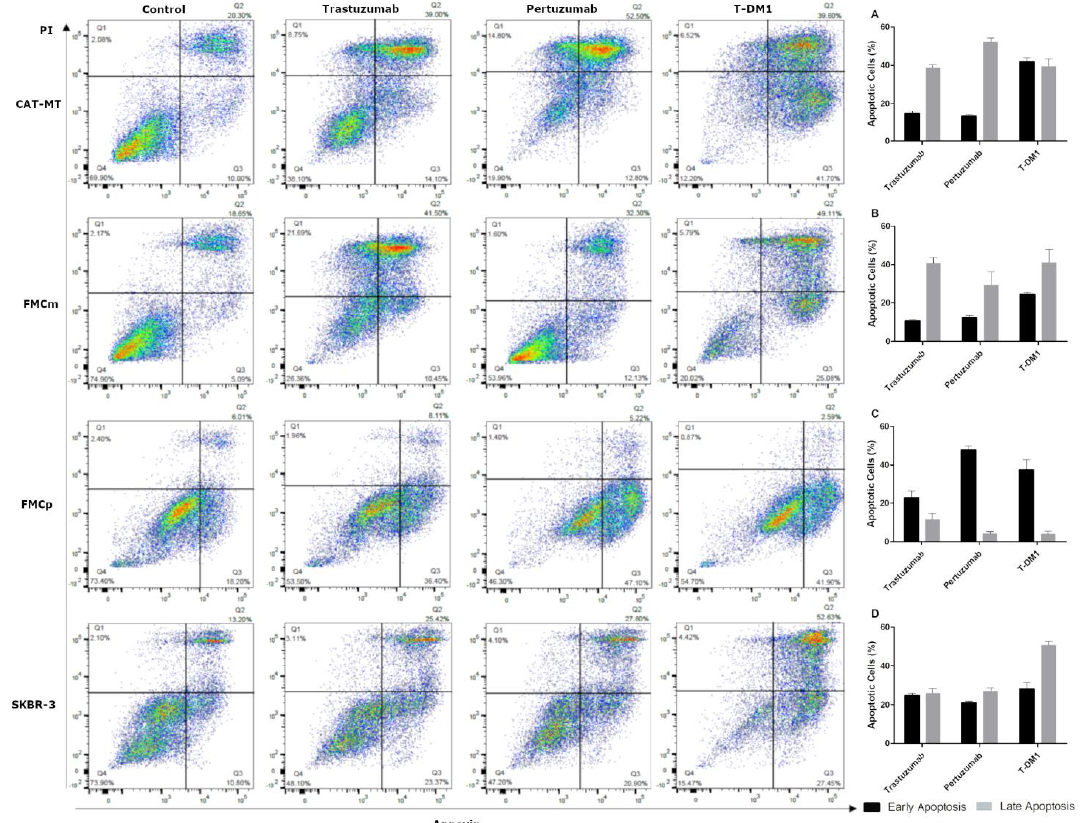
Figure 3. Trastuzumab, pertuzumab and T-DM1 induce apoptosis in the feline cell lines. ( A ) CAT-MT and ( B ) FMCm cell lines presented an increase in cell apoptosis after drugs exposure, being the cells predominantly in late apoptosis phase. ( C ) In the FMCp cell line, cells occurred predominantly in early stage apoptosis. ( D ) The human SKBR-3 cell line had an equilibrated death pattern, between early and late stage apoptosis, with the cells mainly in late apoptosis phase, by expo- sure to T-DM1. The experiment was performed in triplicates and repeated simultaneously three times. 3.3. Combined Exposures of Two Anti-HER2 mAbs and Anti-HER2 mAbs with Lapatinib Showed Synergistic Antiproliferative Effects The combination trastuzumab plus pertuzumab showed synergistic antiproliferative effects in all feline cell lines. In CAT-MT cells the exposure to trastuzumab at 125 µg/mL plus pertuzumab at 2000 µg/mL increased the cytotoxicity from 13.6% to 40.0% ( p < 0.001; Figure 4A). For the FMCm cells, the cytotoxic effect was increased from 15.6% to 45.1% ( p < 0.001; Figure 4B), after exposure to trastuzumab at 125 µg/mL plus pertuzumab at 2000 µg/mL. Finally, in the FMCp cell line, the highest antiproliferative effect was obtained using trastuzumab at 500 µg/mL plus pertuzumab at 2000 µg/mL, increasing the cytotox- icity from 17.1% to 28.8% ( p = 0.018; Figure 4C). In the human SKBR-3 cells, all the conju- gations tested exerted a significant increase of the antiproliferative effect ( p < 0.001; Figure 4D).